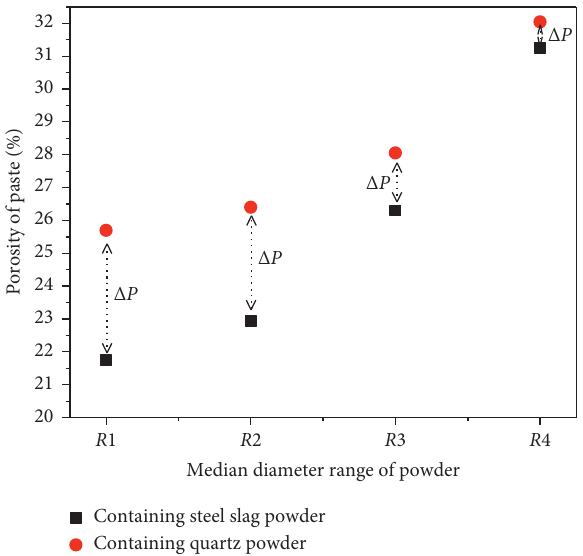
Figure 12: Effects of steel slag and quartz powder on the porosity of blended cement.